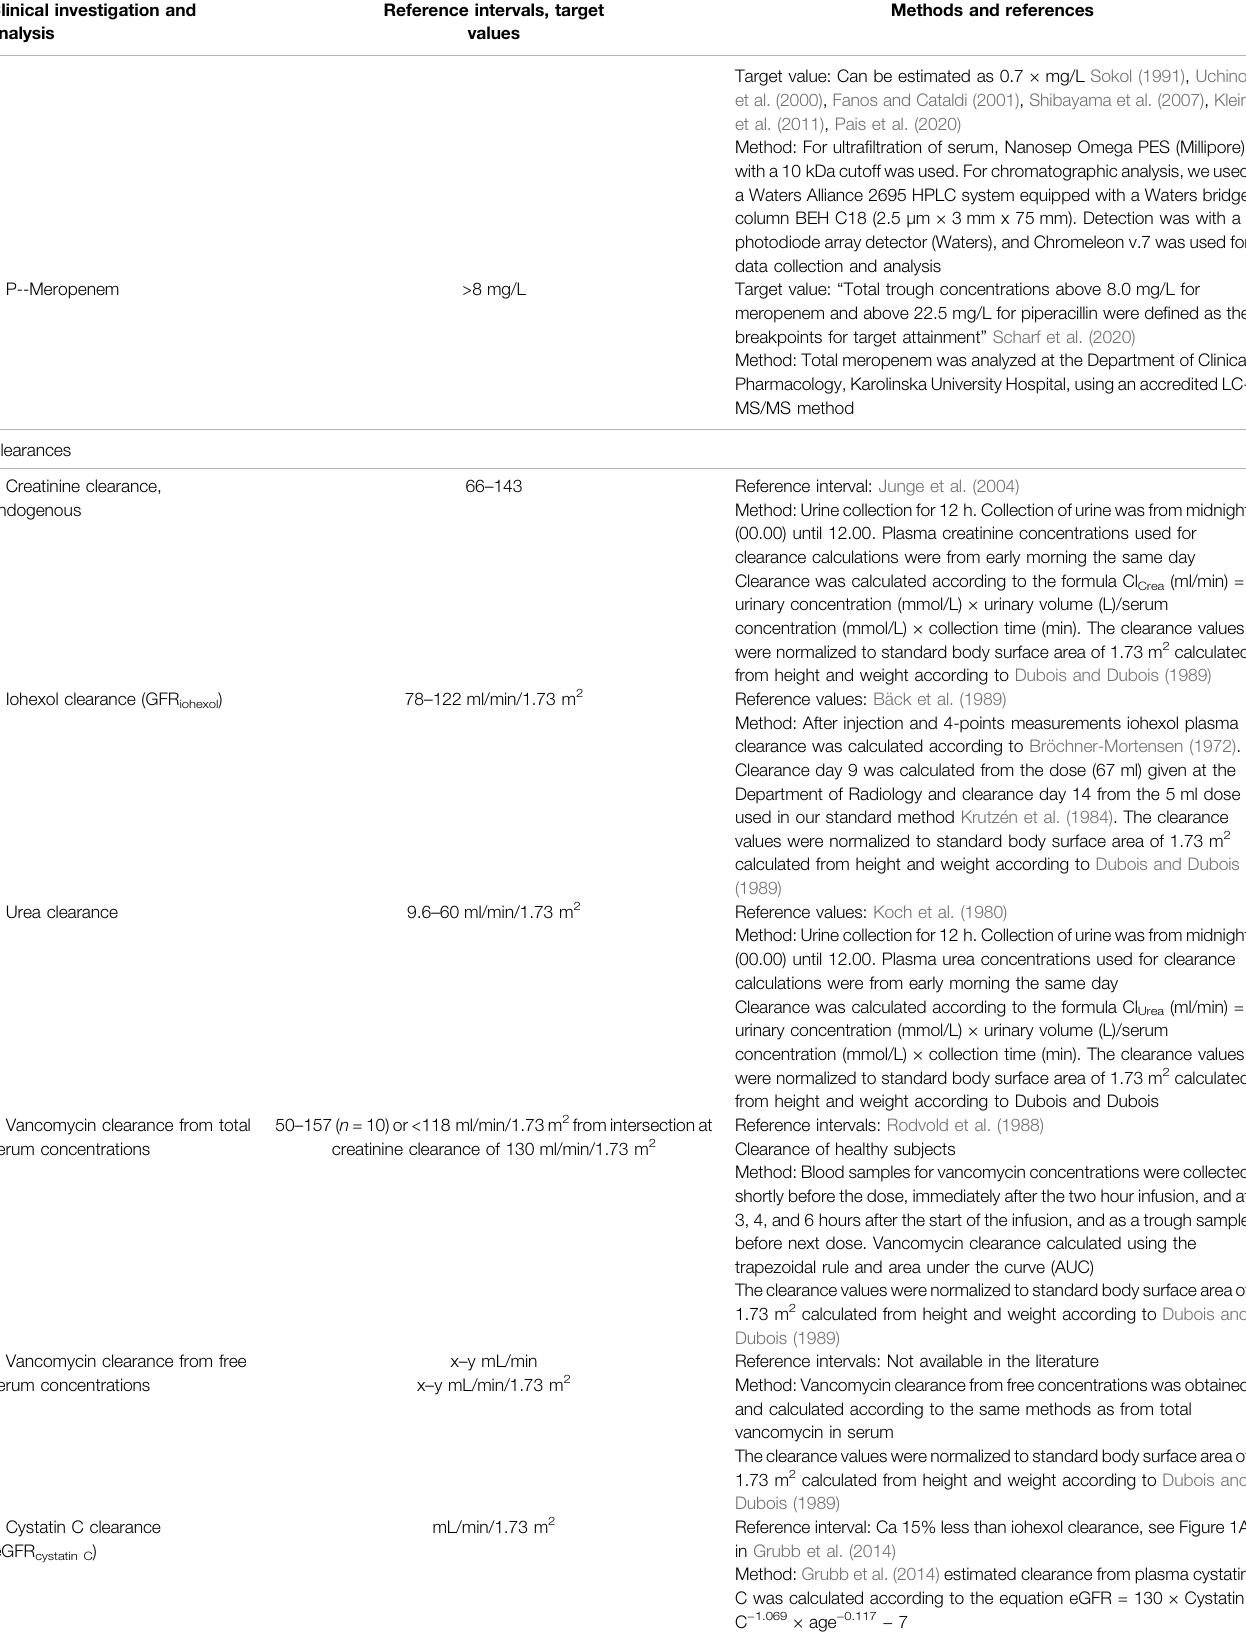
TABLE 1 | ( Continued ) De fi nitions, methods, and reference